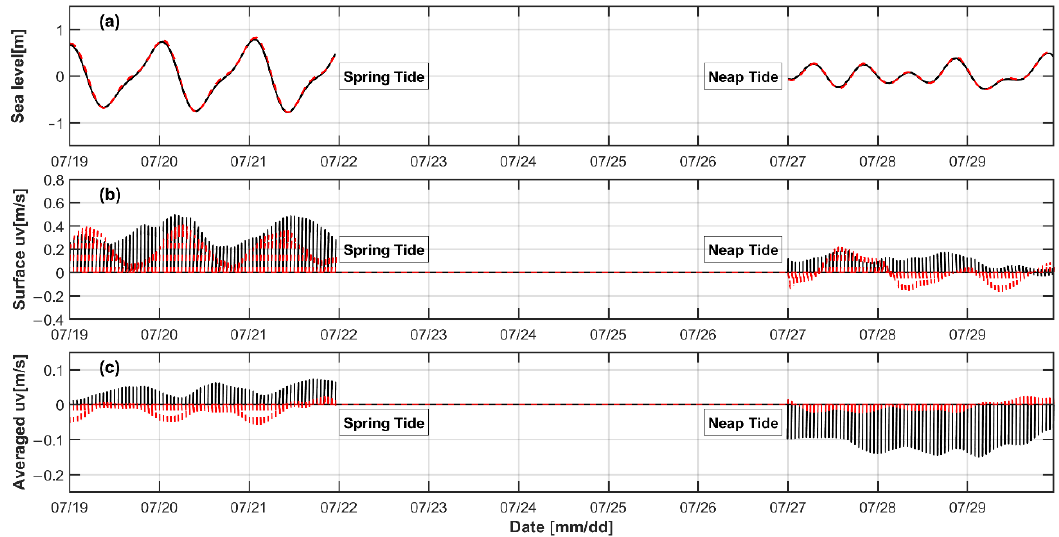
Figure 9. The time-dependent variation of ( a ) the sea level, ( b ) surface flow velocity, and ( c ) depth-averaged flow velocity during the spring tide and the neap tide. The black lines and arrows represent Point A at Section 6 of Figure 1c, while the red lines and arrows represent Point B at Section 2.